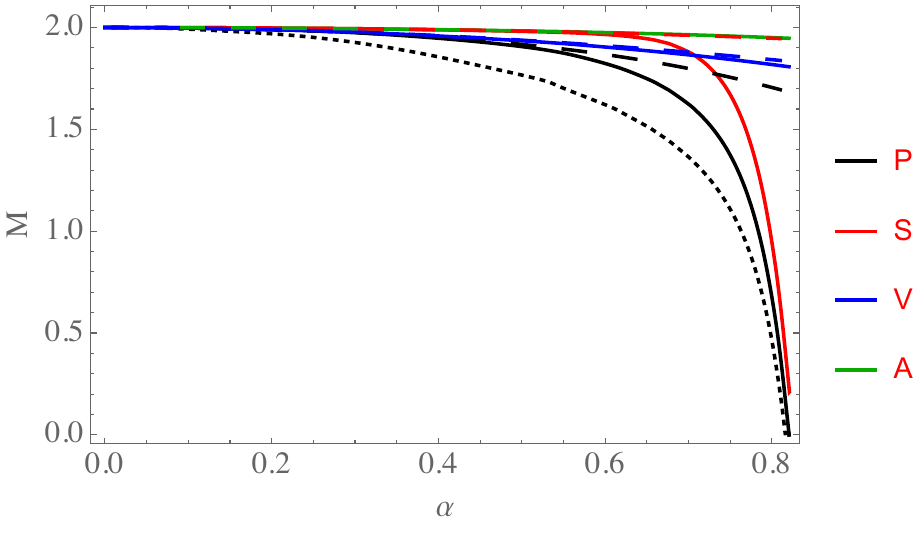
Figure 3 . The pseudoscalar, scalar, vector and axial-vector masses as a function of the gauge coupling with the kernel K ( p; q ; m tot ) and m tot = 1. The moderate UV cuto(cid:11) is used. The dashed lines are the perturbative results to order (cid:11) 4 . The dotted line is the spin 0 mass result with the kernel K ( p; q ; 0).